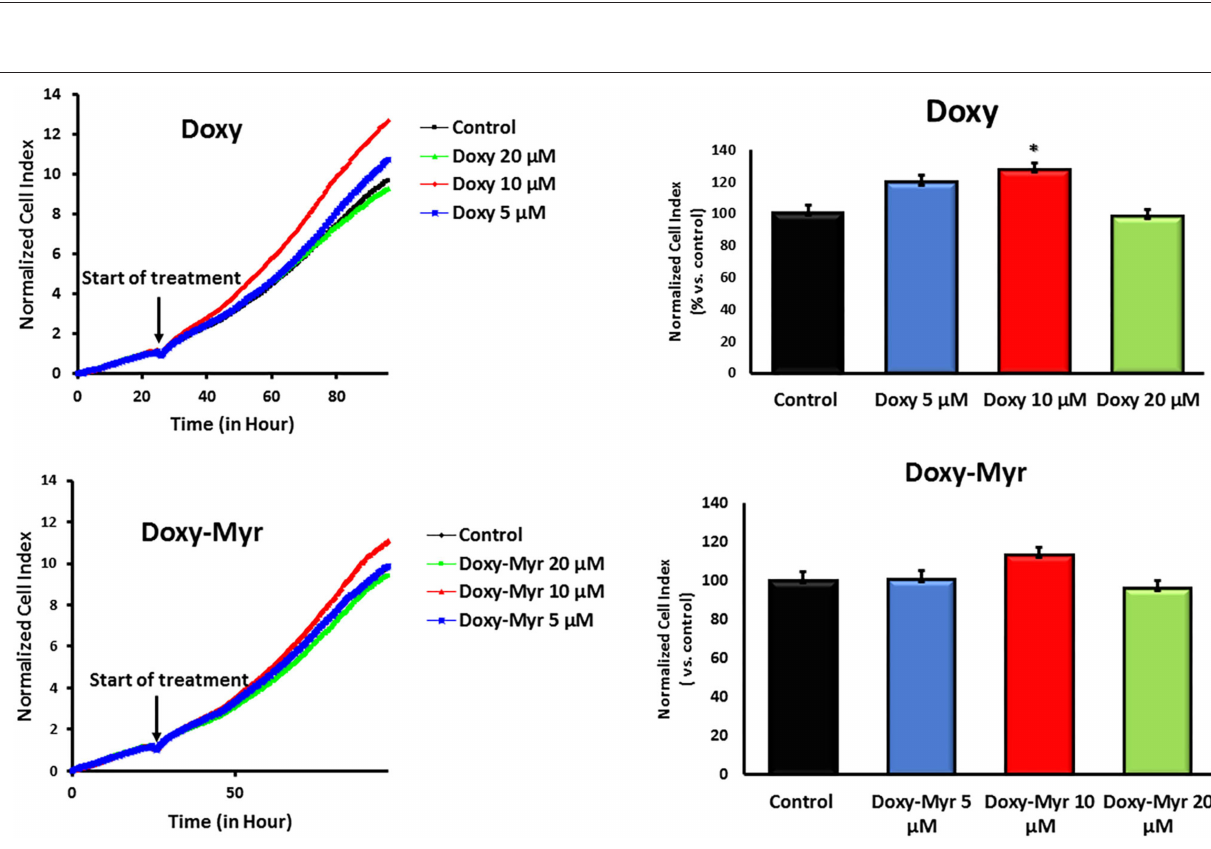
FIGURE 5 | Doxy-Myr does not inhibit the proliferation of MCF7 cell 2D-monolayers. Potential effects of Doxycycline and Doxy-Myr on cell proliferation were determined using MCF7 cell monolayers. Note that Doxycycline and Doxy-Myr did not inhibit the proliferation of MCF7 cells, as assessed using the xCELLigence, in the concentration range of 5–20 µ M. * p <